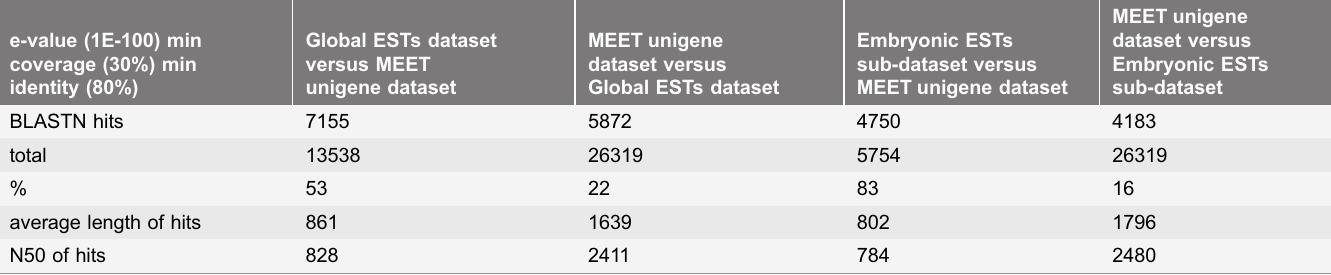
Table 2. Comparison of the present C. capitata MEET dataset with the available C. capitata